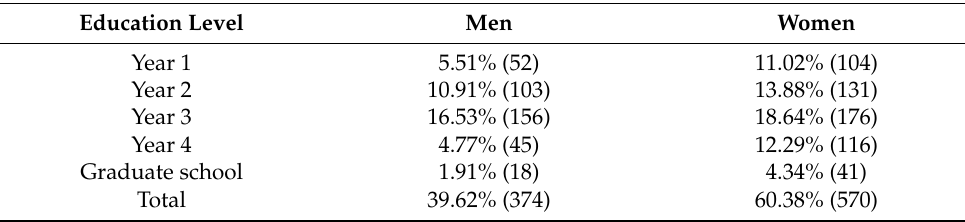
Table 1. Participant distributions based on gender and education